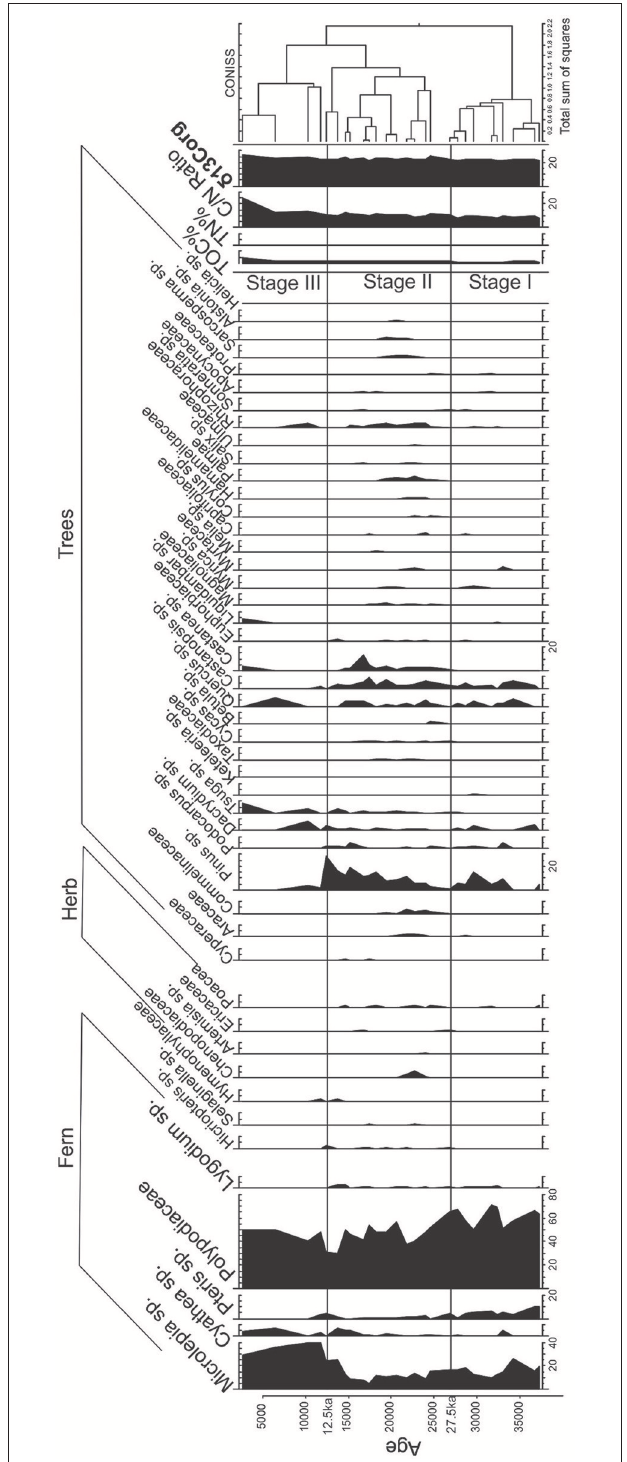
FIGURE 4 | Diagram of pollen and the geochemical data of the core NS07-25 in the NanshaTough. Pollen data has divided in to three zonation according to the Hierarchical Cluster Analysis using Coniss, in where geochemical data also follow the same zonetion clearly.